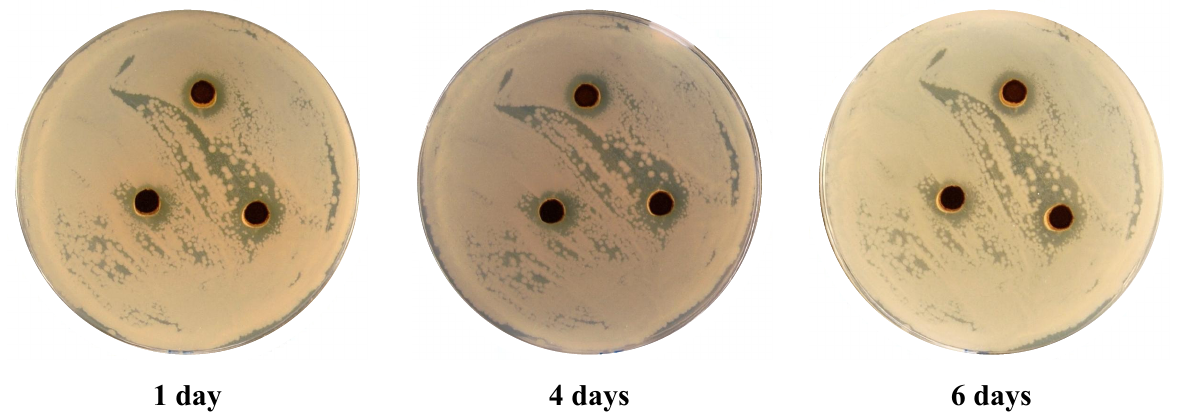
Figure 4. E. coli . treated with 100 mg/mL of dye 9 after 1, 4, and 6 days of